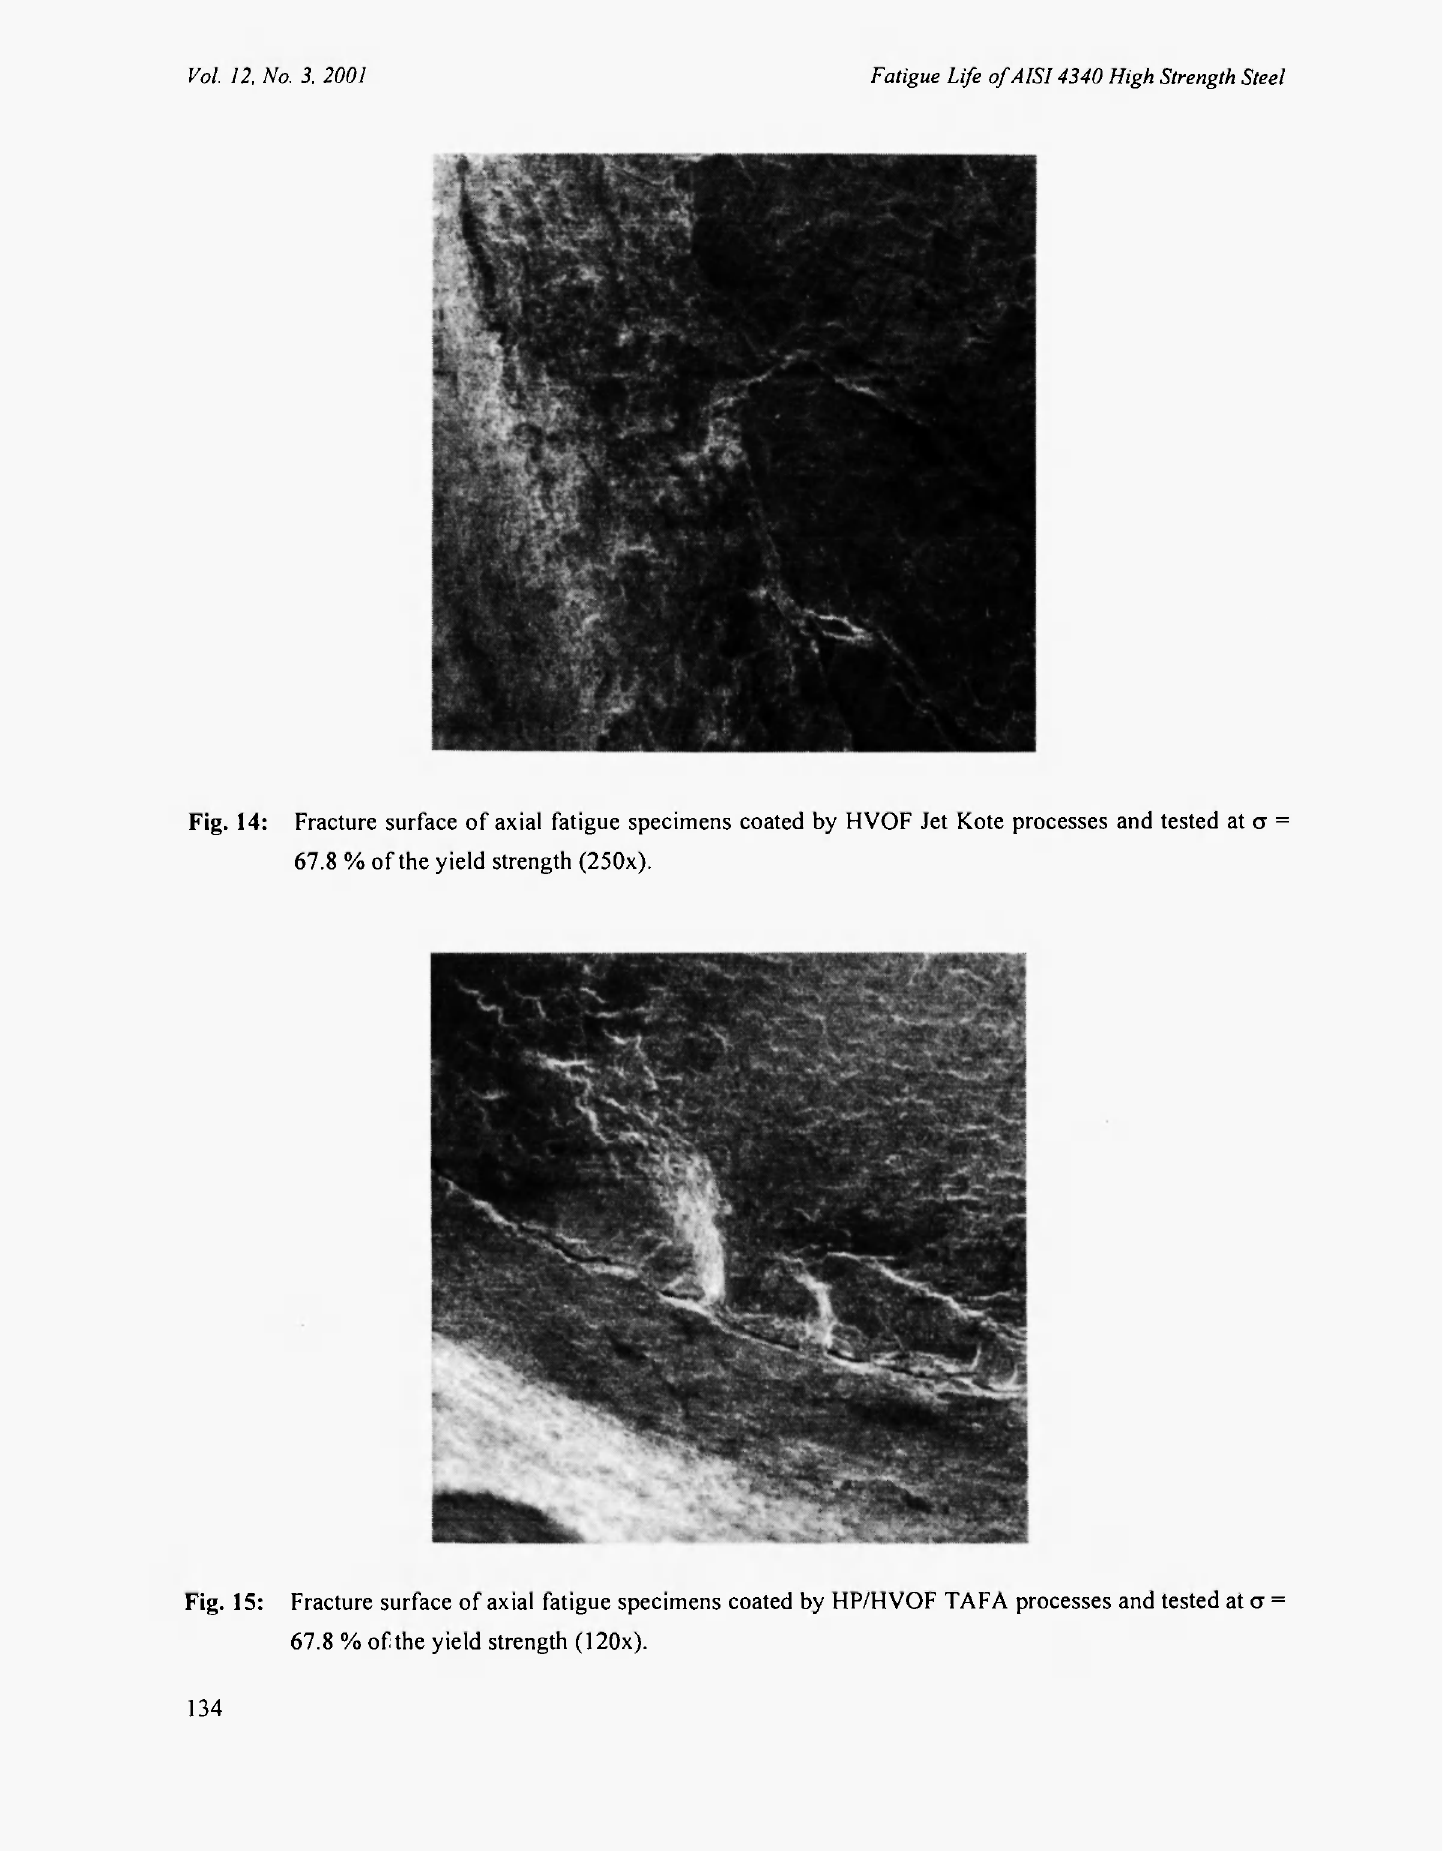
Fig. 15: Fracture surface of axial fatigue specimens coated by HP/HVOF TAFA processes and tested at σ = 67.8 % of the yield strength